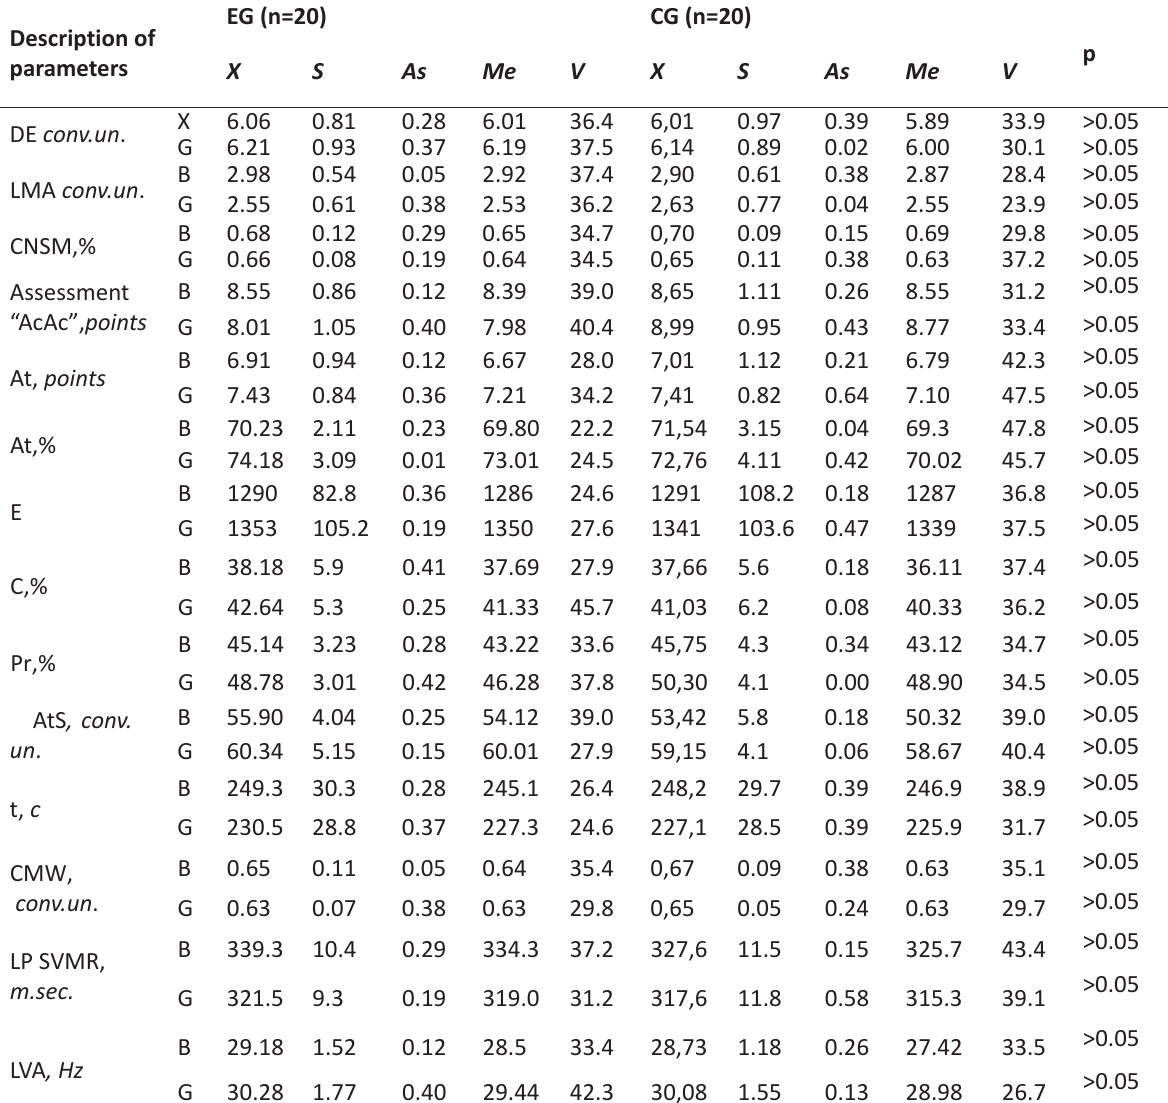
Table 1. Indicators of psycho-physiological functions parameters of students with ophthalmologic diseases at the beginning of experiment EG (n=20) Description of parameters DE conv.un . LMA conv.un